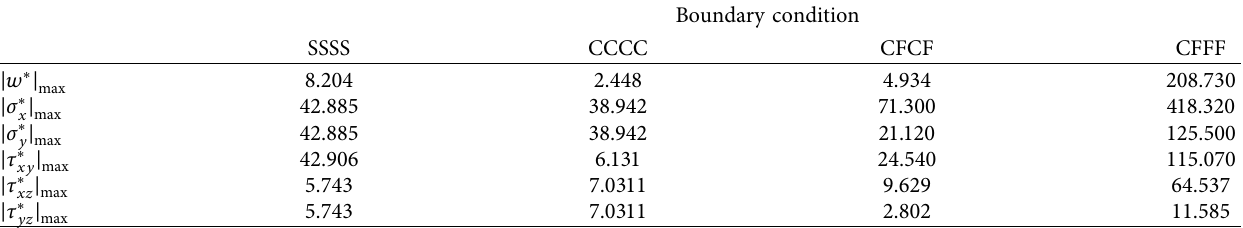
Table 4: The maximum values of deflection and stress of FGM nanoplate subjected to uniformly distributed load q and ψ � 1.